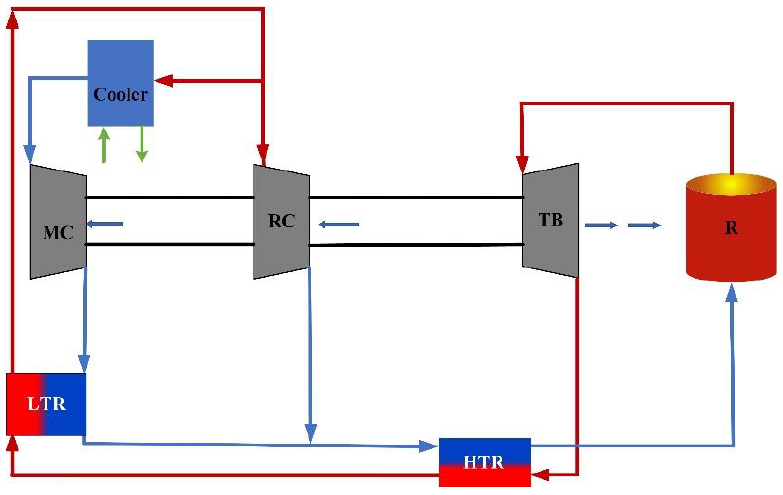
Figure 1. Diagram for the recompression Brayton cycle.